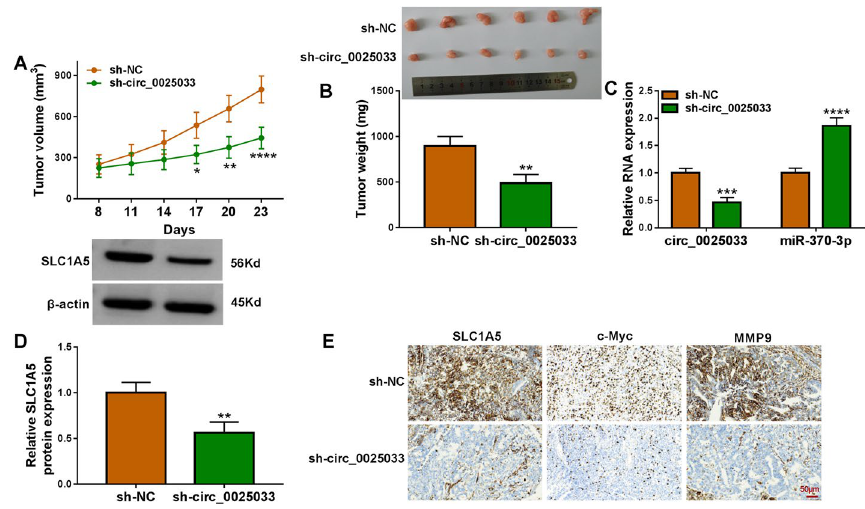
Fig. 7 circ_0025033 absence repressed tumor growth in vivo. A and B Effects of sh-circ_0025033 on tumor volume and weight. C circ_0025033, hsa_miR-370-3p, and SLC1A5 were examined using qRT-PCR and western blot in tumor tissue. E IHC analysis was used to detect SLC1A5 , c-Myc, and MMP9 expression. * P < 0.05, ** P < 0.01, *** P < 0.001, **** P <